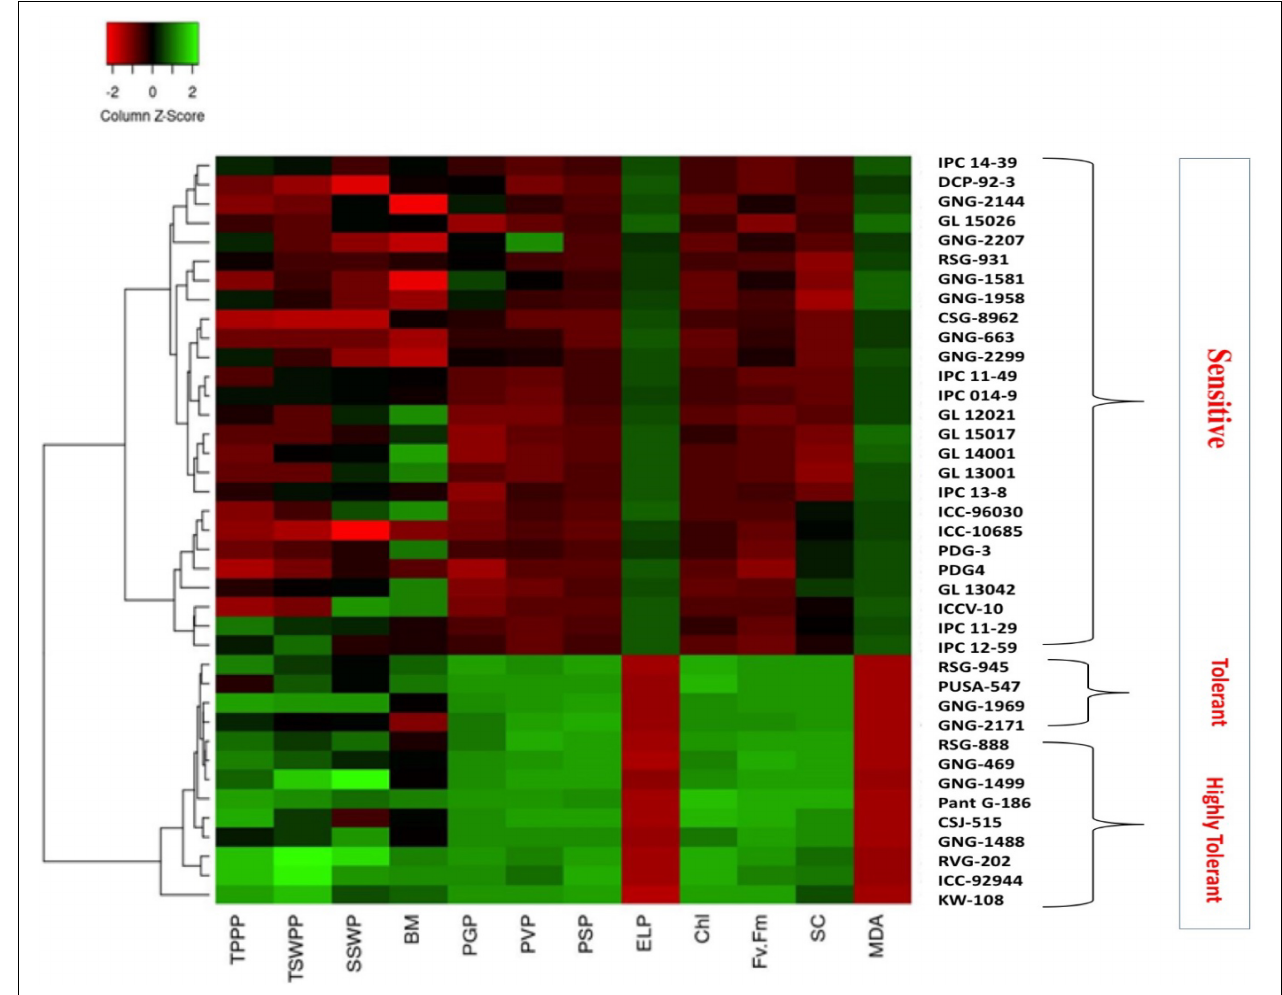
FIGURE 9 | Heat map based on the response of chickpea genotypes to heat stress in 2018–2019.